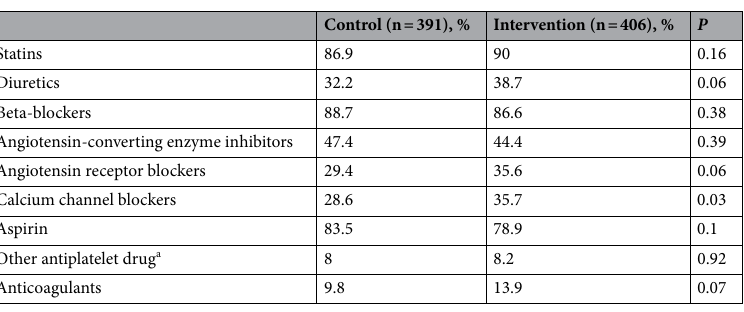
Table 2. Medication at 36 months. a Other antiplatelet drug, e.g., clopidogrel, ticagrelor.